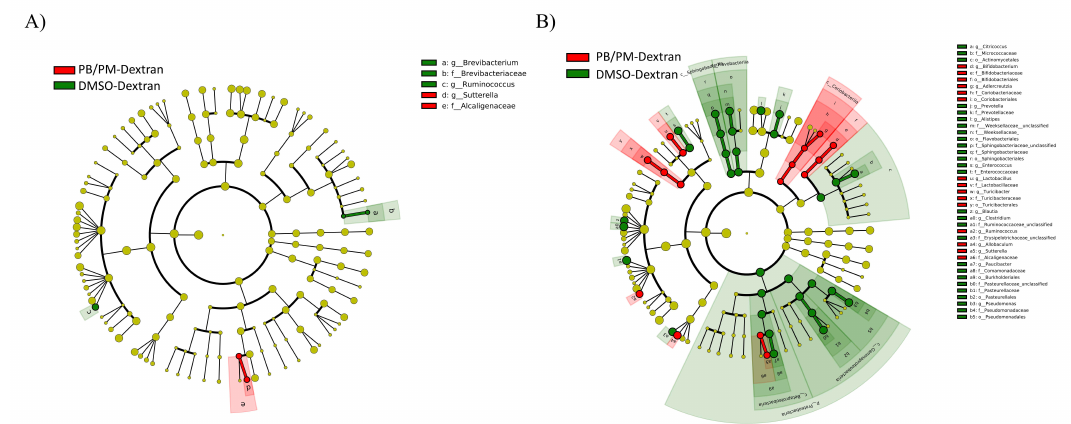
Figure 4. Linear discriminant analysis (LDA) e ff ect size (LEfSe; Kruskall–Wallis ( p < 0.05); Pairwise Wilcoxon ( p < 0.05); logarithmic LDA score > 2.0) of the fecal microbiota of mice exposed to either DMSO-Dextran or PB / PM-Dextran. Taxa with increased sequence abundance after ( A ) 48 h or ( B ) 9 months post GWI exposures are indicated for PB / PM-Dextran (Red), DMSO-Dextran (Green) groups. Taxonomic rank labels are provided before bacterial names: “p_; c_; o_; f_; g_” indicate phylum, class, order, family, and genus, respectively. Letters and numbers within the cladograms refer to bacterial names located in the key to the right of each cladogram.